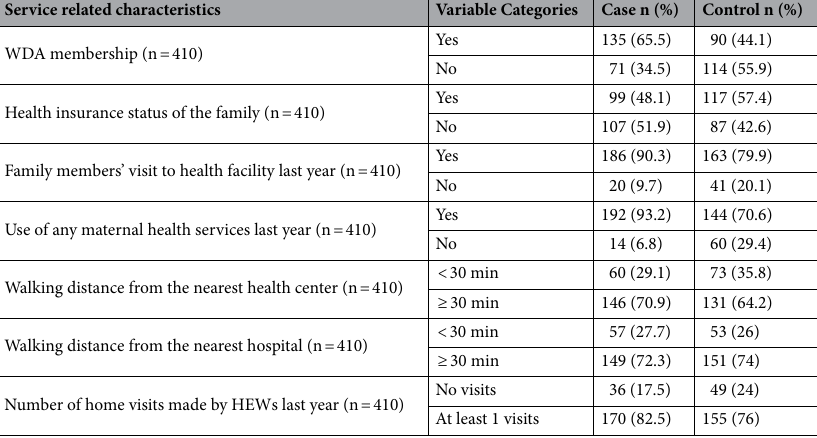
Service related